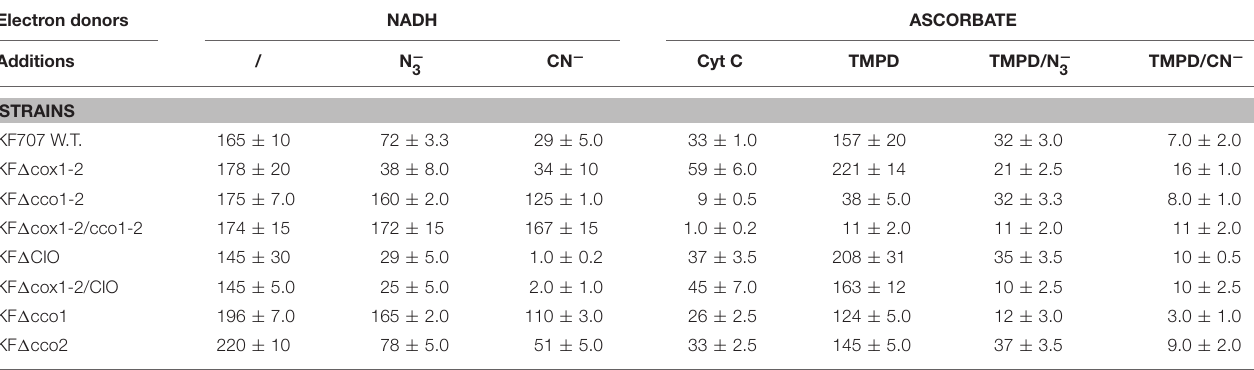
TABLE 3 | Respiratory activities in membranes from KF707 W.T. and oxidase mutant cells grown, until the stationary phase (OD 600 nm ) 0.7–0.9, in glucose (Gc) as sole carbon source. Electron